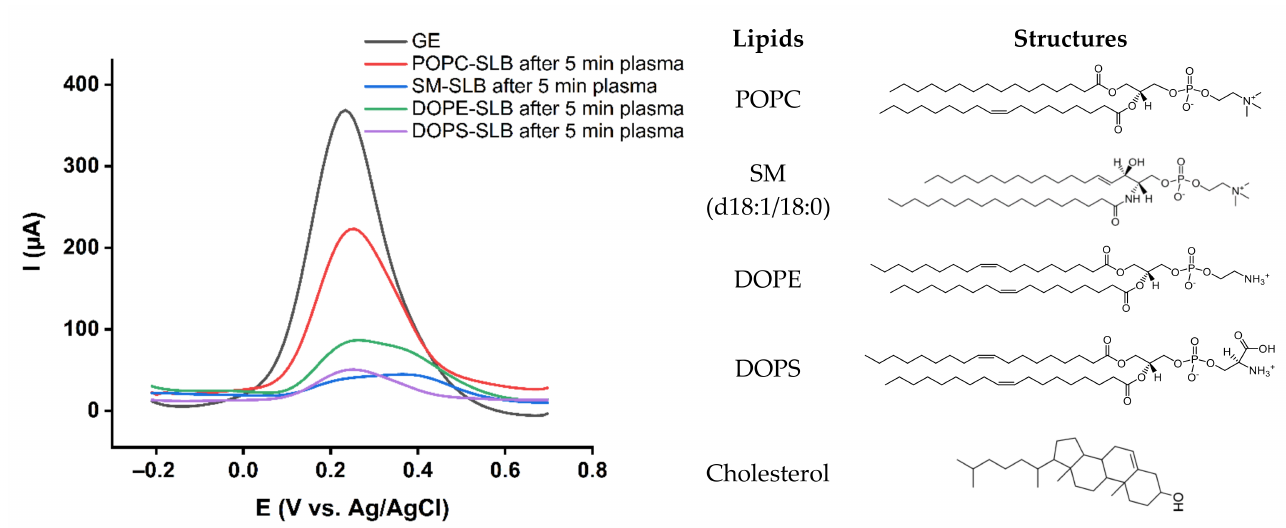
Figure 4. Differential pulse voltammograms of 10 mM K 4 [Fe(CN) 6 ] in PBS for the gold electrode (GE) and gold supported lipid bilayers from POPC (phosphatidylcholine class), SM (d18:1/18:0) (sphingo- sylphosphorylcholine class), DOPE (phosphoethanolamine class), and DOPS (phosphoserine